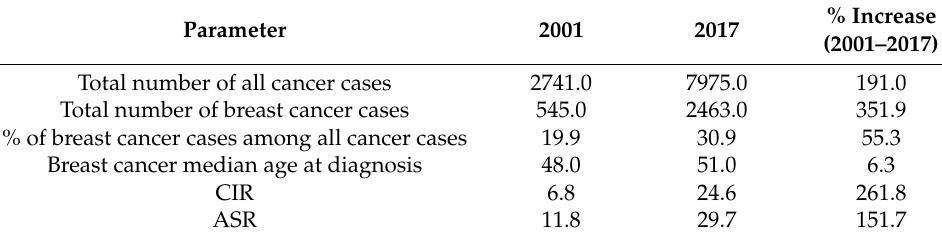
Figure 3. Breast cancer cases and age at diagnosis in the Saudi female population. ( A ) The number ( y -axis) of breast cancer cases among the Saudi female population. ( B ) Percentage ( y -axis) of breast cancer cases of all Saudi female cancers. ( C ) Median age at diagnosis indicated in the y -axis (for the years 2001–2003, only the mean was reported). The x -axis represents the years for the period of 2001–2017. Table 2. Summary of Breast Cancer Incidence Parameters Among the Saudi Female Population.